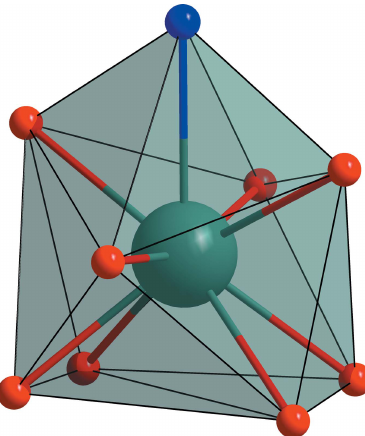
Figure 2 Representation of a polyhedron around a central Sr ion spanned by the NO 8 coordination environment. Color code: Sr teal, N blue, O red, polyhedron borders black and polyhedron faces